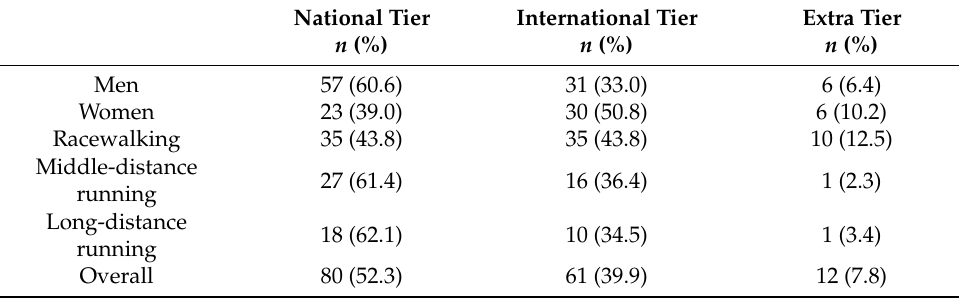
Table 3. Number of athletes of different